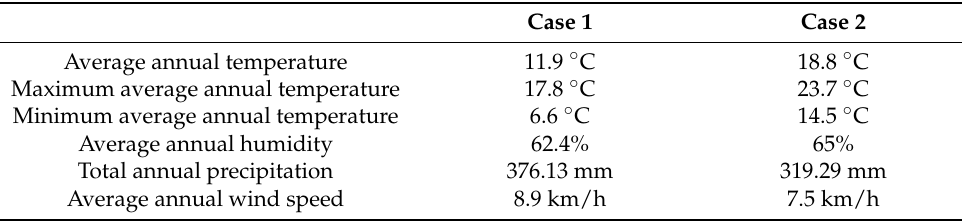
Table 2. Climate conditions of the areas considered as study cases for the year 2021. Case 1: Ávila, Case 2: Alicante [35].